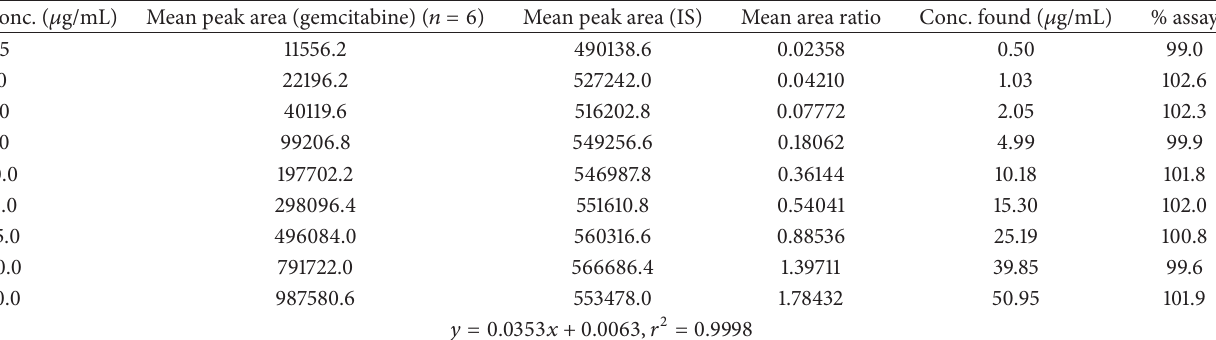
Table 1: Linearity data of the proposed method.